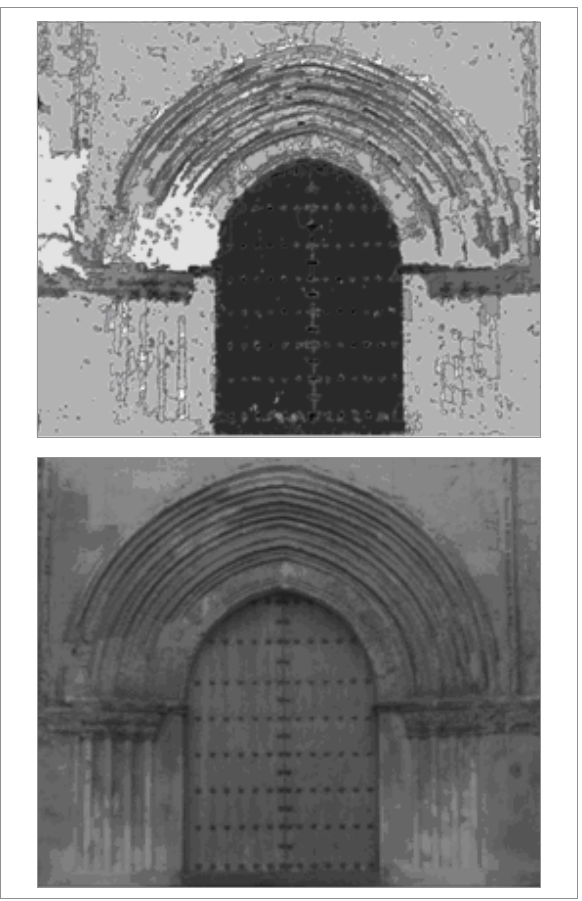
Figure 5: Comparison between the segmented composition (upper) and the original composition (lower) of the main door of the Santa